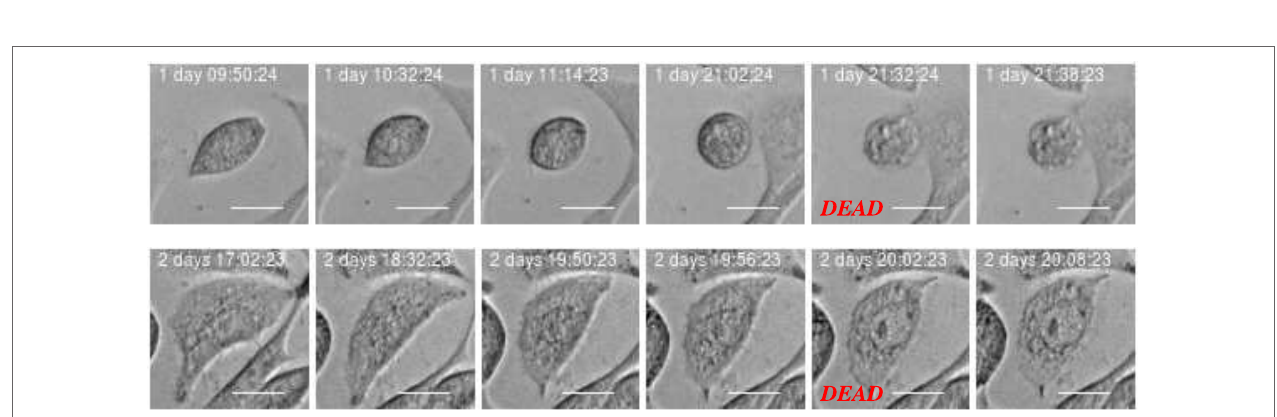
FigUre 5 | Example of cell death classified as “necrosis-like” based on imagery recordings. Typical features are cytoplasmic granulation and membrane rupture. The necrotic cell looks like fixed/frozen. This morphology can facilitate automatic and objective classification and determination of time for cell death. Scale bar: 20